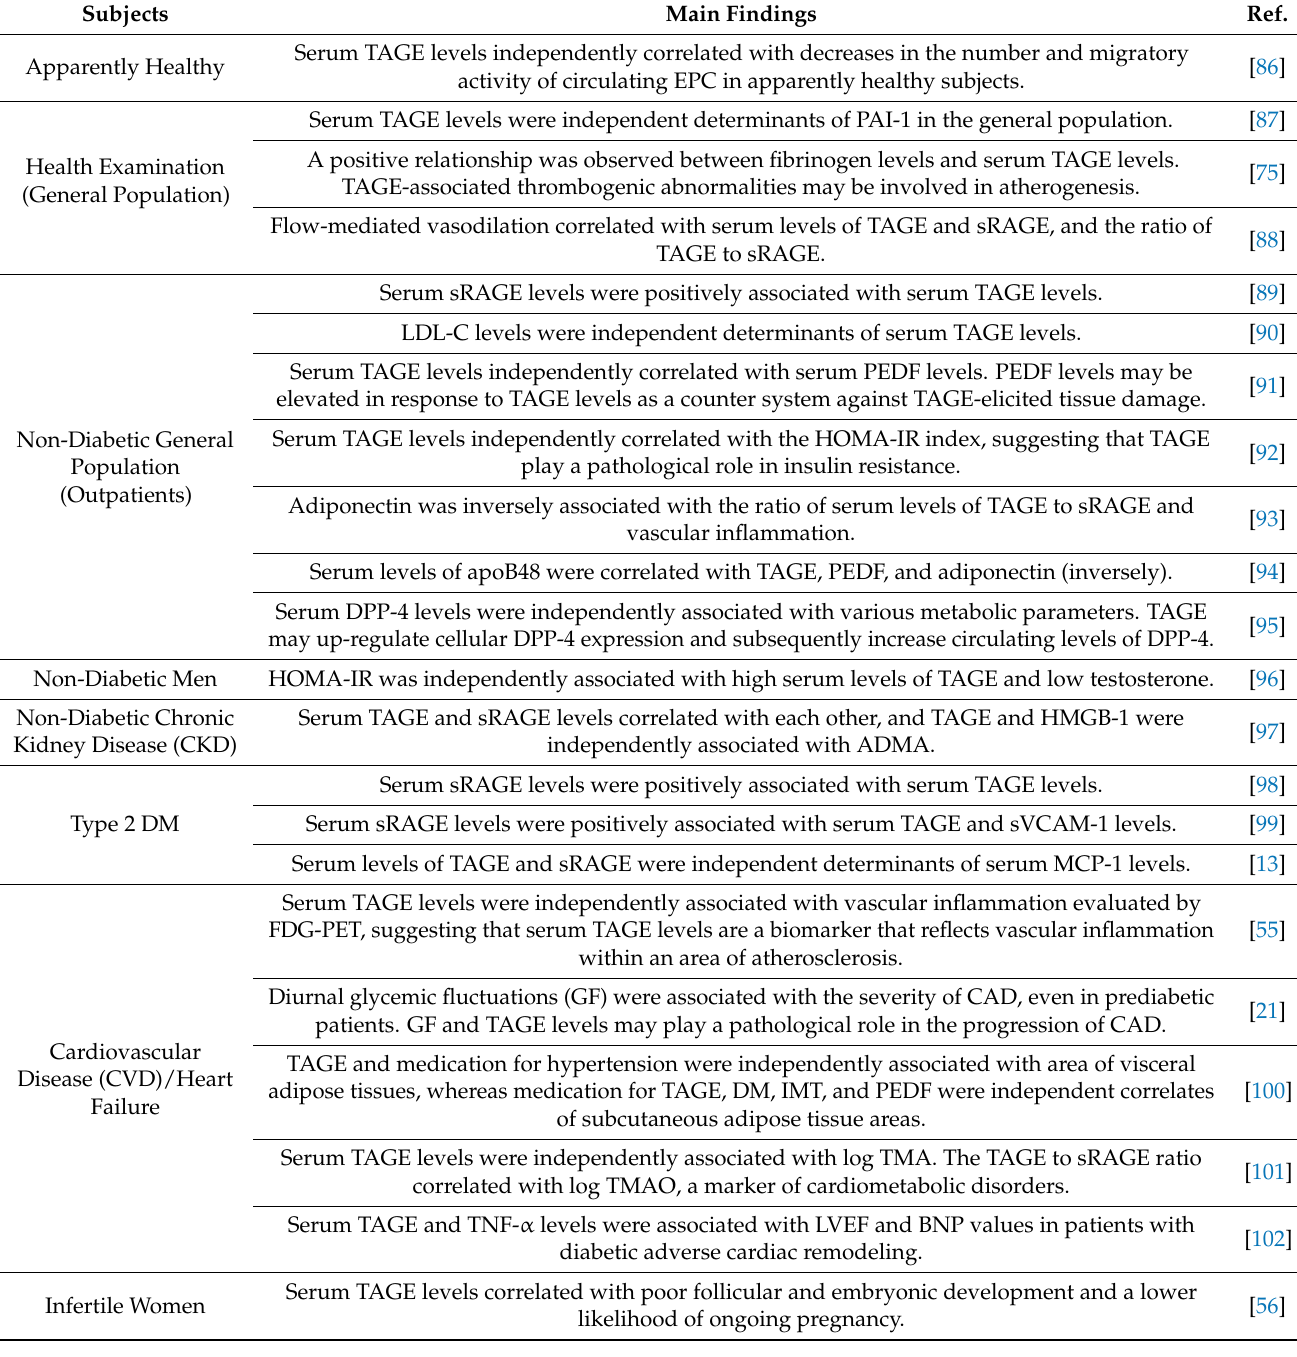
Table 1. Clinical relevance of circulating TAGE